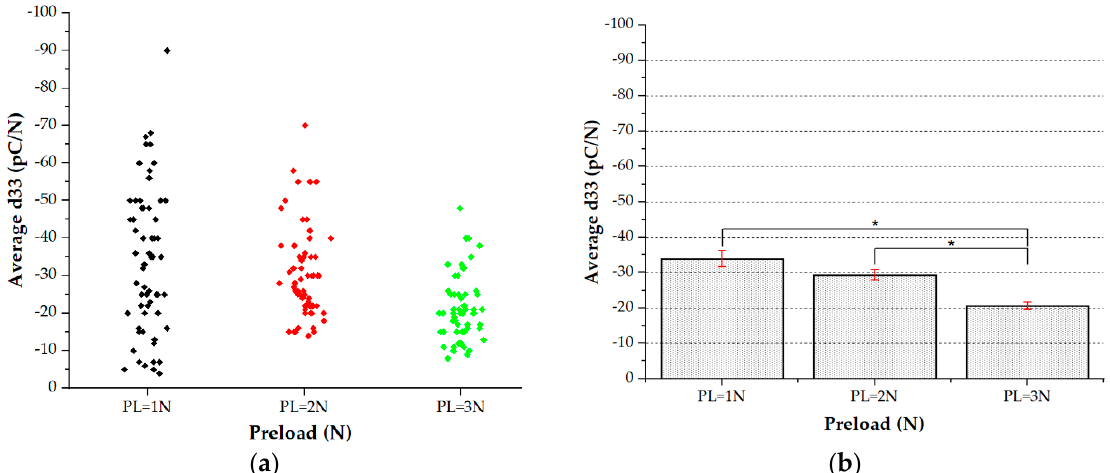
Figure 12. ( a ) Cloud distribution of working palm sensors. ( b ) Statistical study: One-way analysis of variance (ANOVA) ( p < 0.05), average d 33 vs. preload.